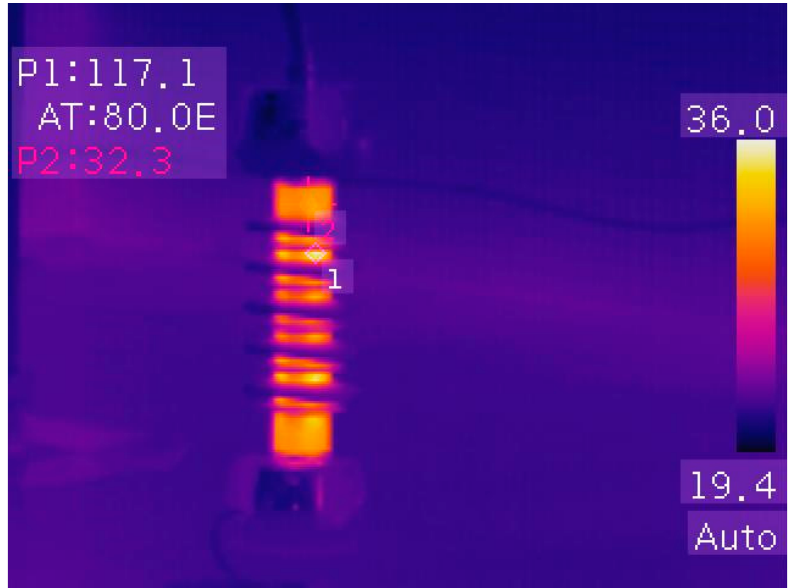
Figure 1. Thermal image of a MOSA with surface pollution in a laboratory.